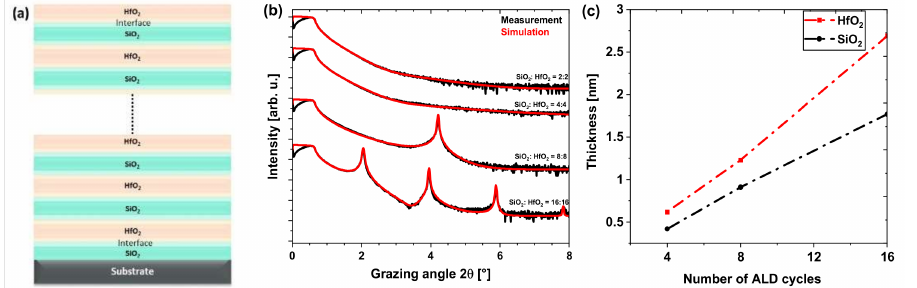
Figure 9. ( a ) Schematic representation of SiO 2 :HfO 2 heterostructures by PEALD, ( b ) measured and simulated X-Ray reflectivity curves of SiO 2 :HfO 2 heterostructures grown on FS, and ( c ) constituent layers thickness variation as a function of PEALD